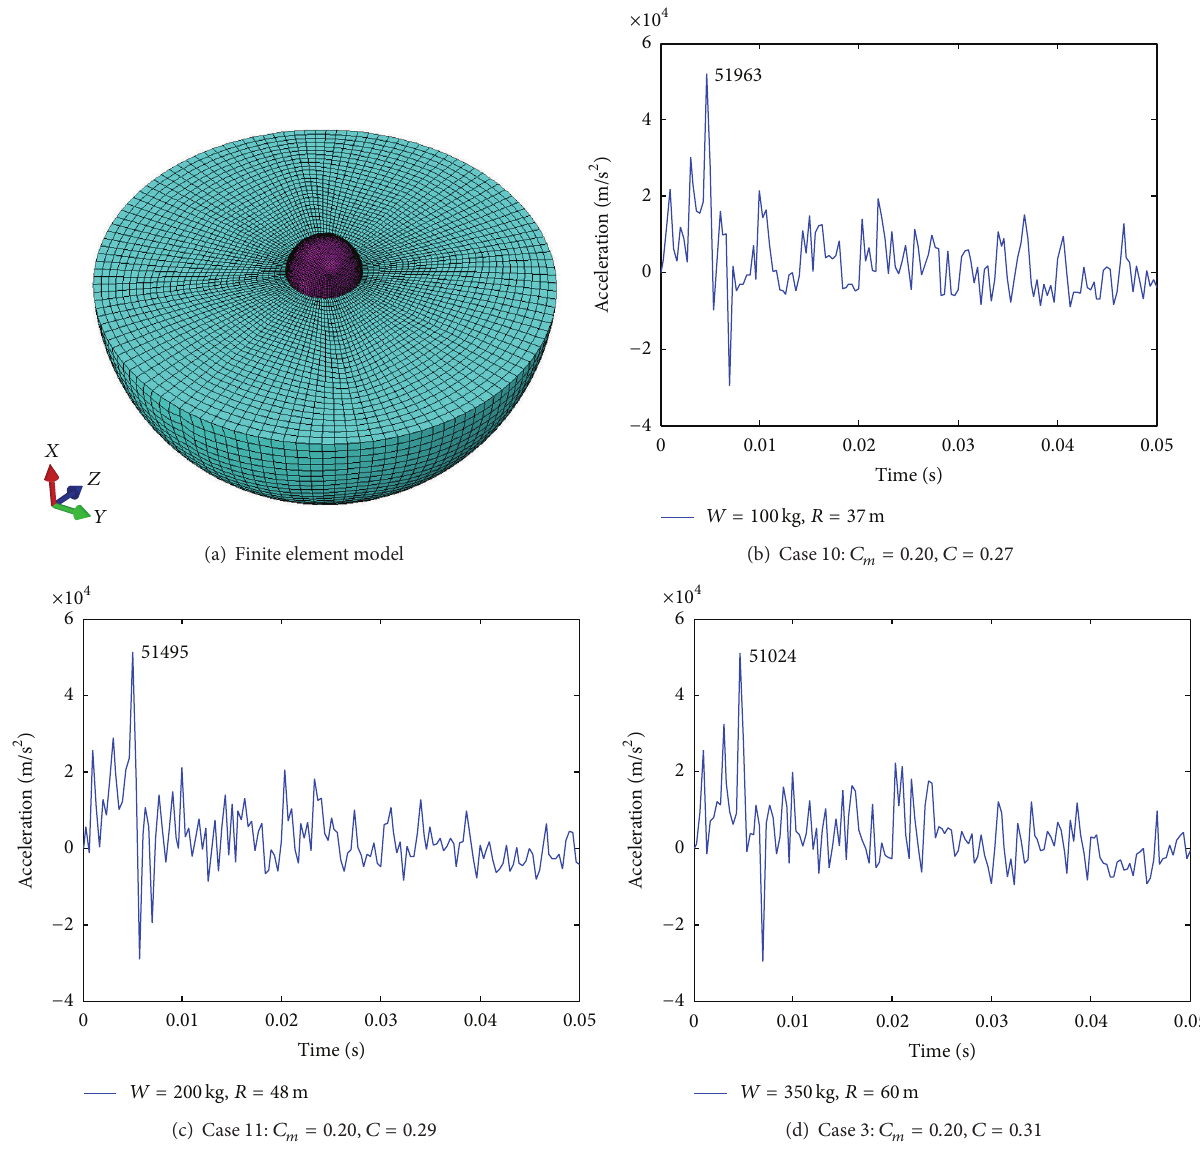
Figure 10: The finite element model and time history of dynamic acceleration of spherical